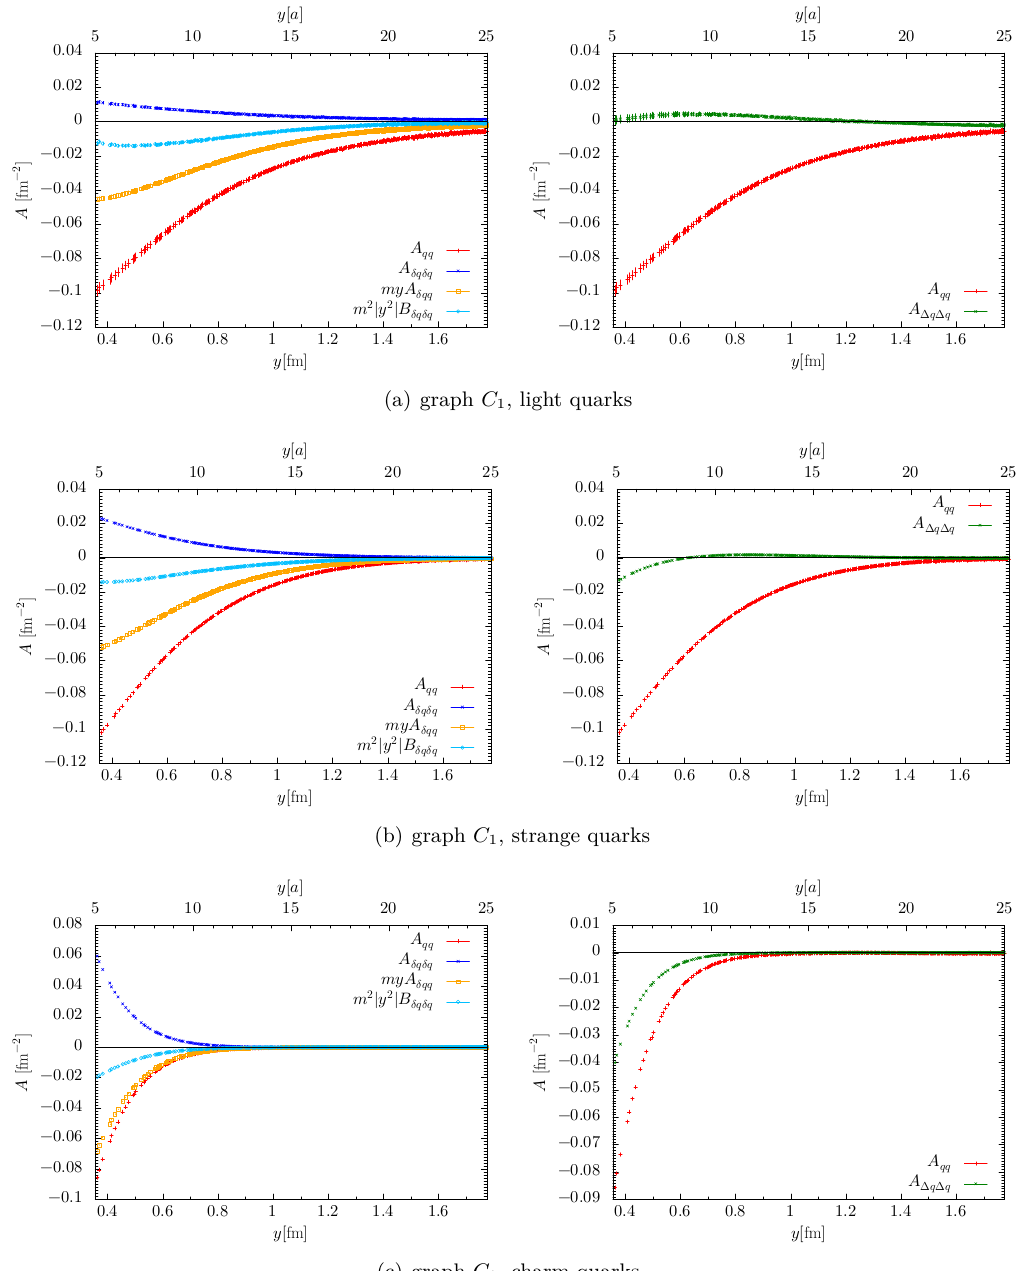
(c) graph C 1 , charm quarks Figure 20 . Effects of transverse (left) and longitudinal (right) polarisation for graph C 1